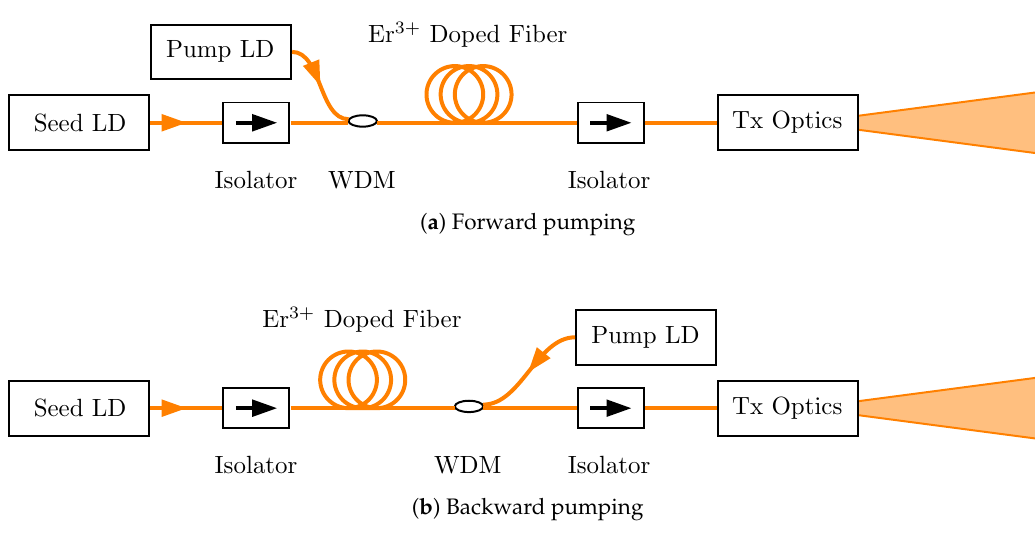
Figure 8. EDFA pumping